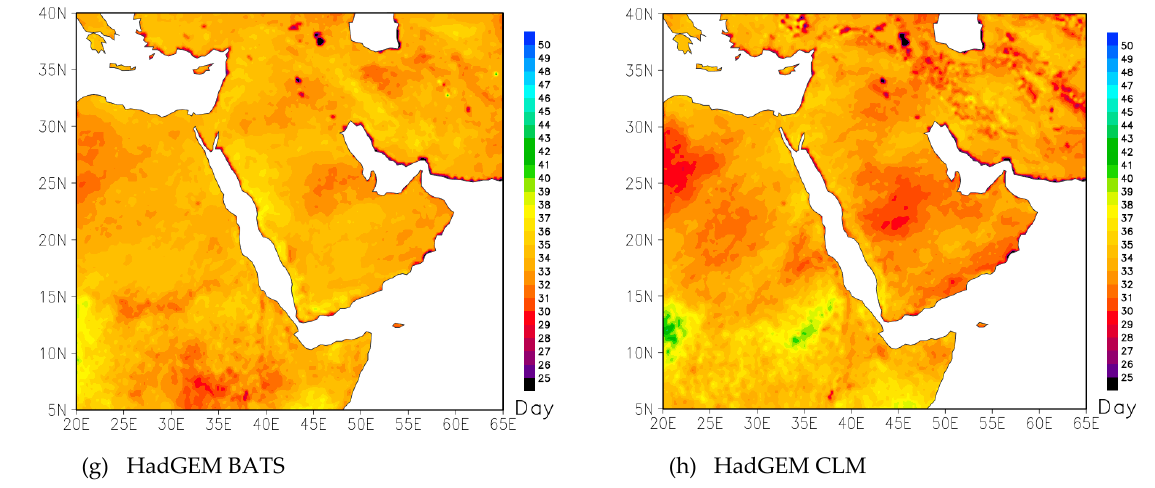
Figure 6. Spatial distribution of annual cold days (TX10p) for ( a ) ERA–Int BATS, ( b ) ERA–Int CLM, ( c ) ECHAM6 BATS, ( d ) ECHAM6 CLM, ( e ) GFDL BATS, ( f ) GFDL CLM, ( g ) HadGEM BATS, and ( h )